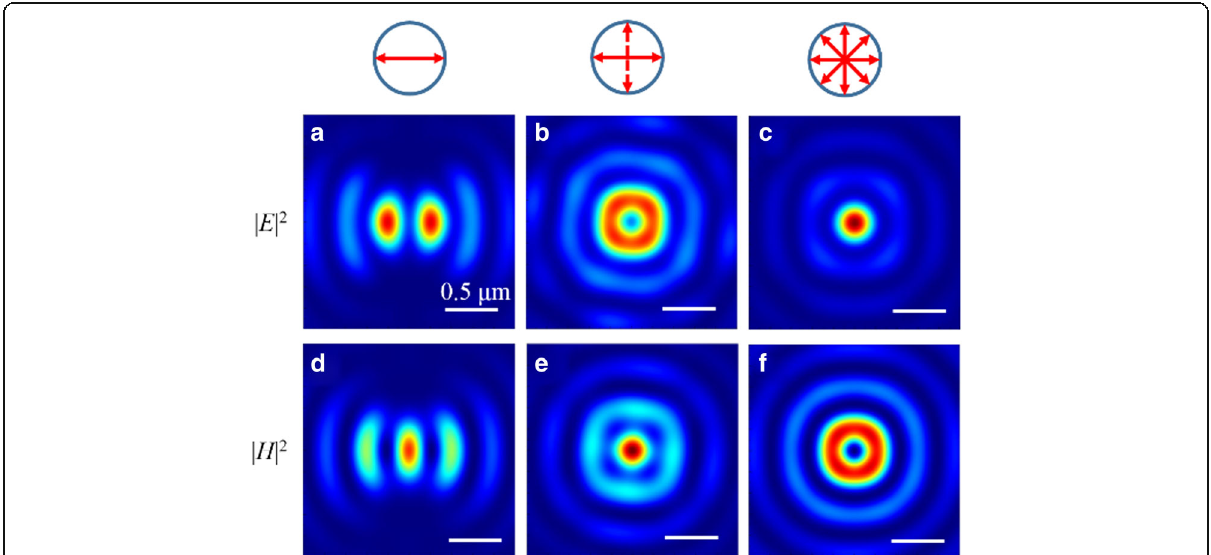
Fig. 12 The normalized intensity patterns of the electric field | E | 2 and magnetic field | H | 2 in the focal plane when the NRPL is illuminated by the polarized light. a | E | 2 and d | H | 2 distribution with linearly polarized incident light. b | E | 2 and e | H | 2 distribution with circularly polarized incident light. c | E | 2 and f | H | 2 distribution with radially polarized incident light